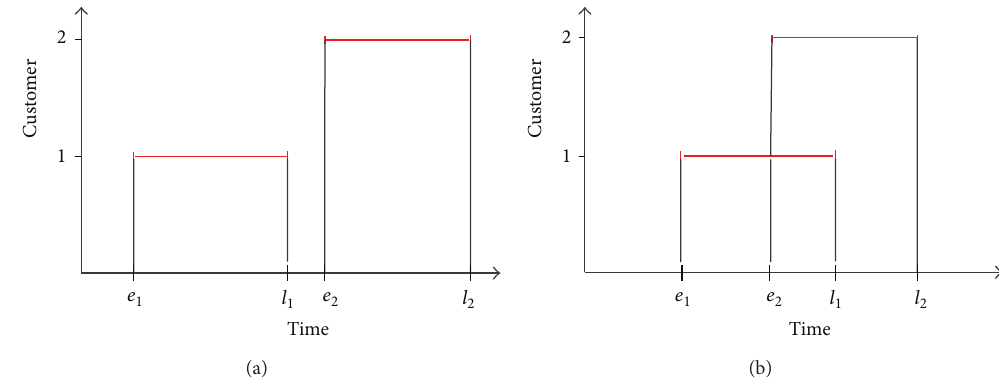
Figure 2: Time windows for a customer pair: (a) nonoverlapping time windows and (b) overlapping time windows.